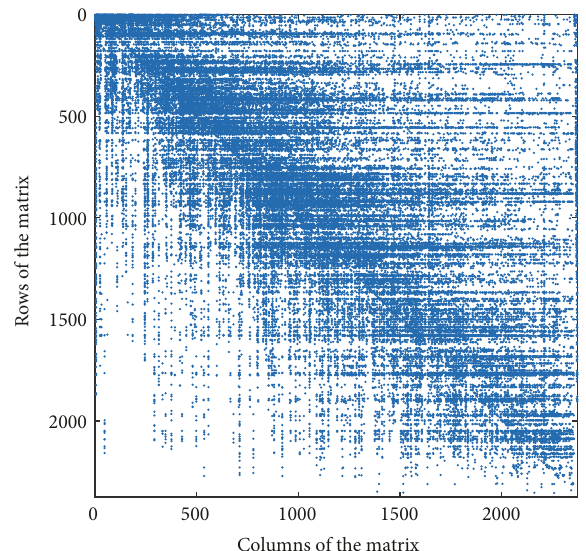
Figure 12: Nonzero elements of adjacency matrix for Wikipedia who-votes-on-whom network after removing sources. The number of nonzero elements of adjacency matrix is 57,650.